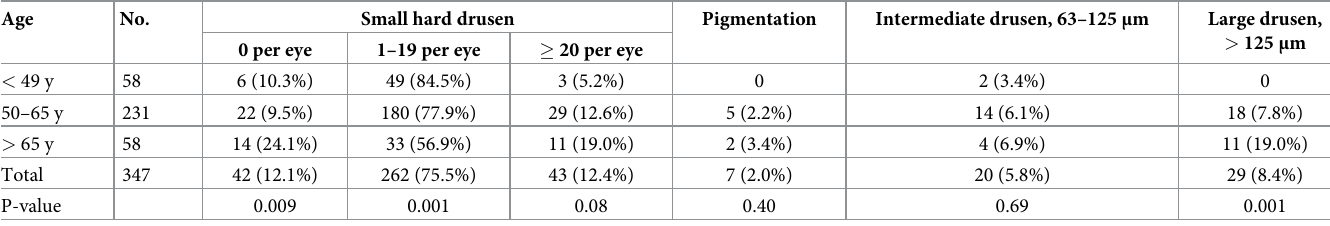
The classification was based on the averages of the participants’ two eyes. The primary classification is non-hierarchical, i.e., a given participant is represented in all classes. However, for pigment and drusen � 63 μ m, the characteristic of having none of these is evident only in participants not being listed as having them. The secondary classification by the number of small hard drusen per eye permits participation in only one out of the three subclasses. Pearson’s chi-square test was applied for a column-wise p-value comparing each age group within each phenotype category. The parentheses show the fraction of affected participants within each age